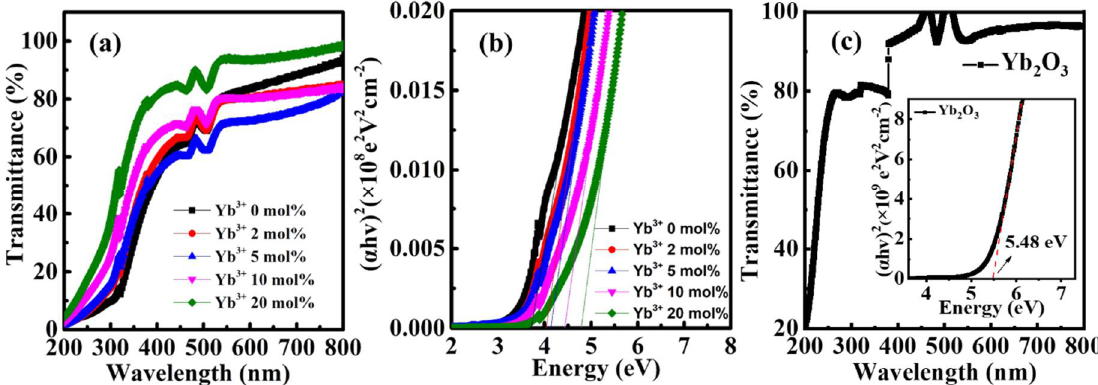
Figure 3. ( a ) Optical transmittance spectra, ( b ) estimated bandgaps of In-Yb-O thin films with indicated Yb ratios, and ( c ) optical transmittance spectra of Yb 2 O 3 (inset: estimated bandgap of Yb 2 O 3 ).